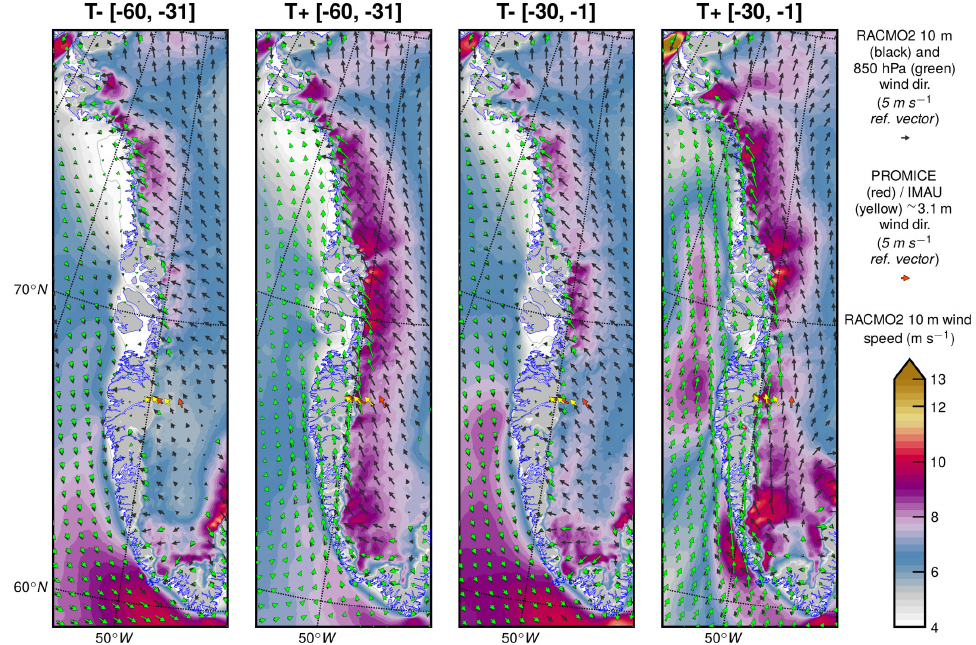
Figure 8. Composites of RACMO2 10m (black arrows) and 850hPa (green arrows) vector winds for the T + and T − events at KAN_B preceding the Baffin Bay date of sea ice advance (DOA), 2011–2015. Wind observations from PROMICE (red arrows) and IMAU (yellow arrows) are overlaid for